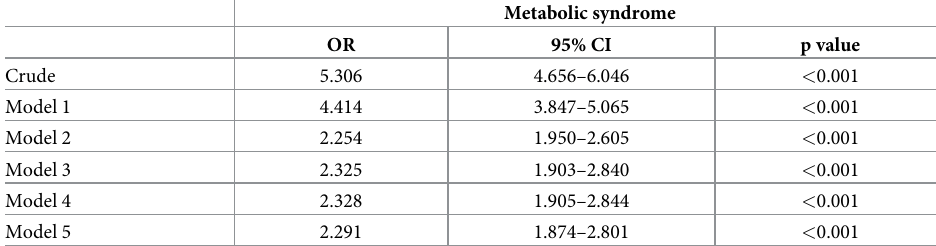
Table 2. Association between metabolic syndrome and